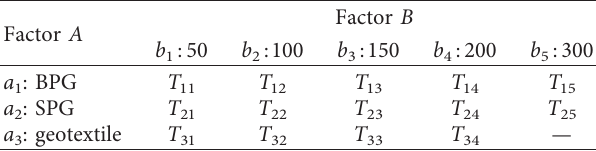
Table 2: Basic information of the test